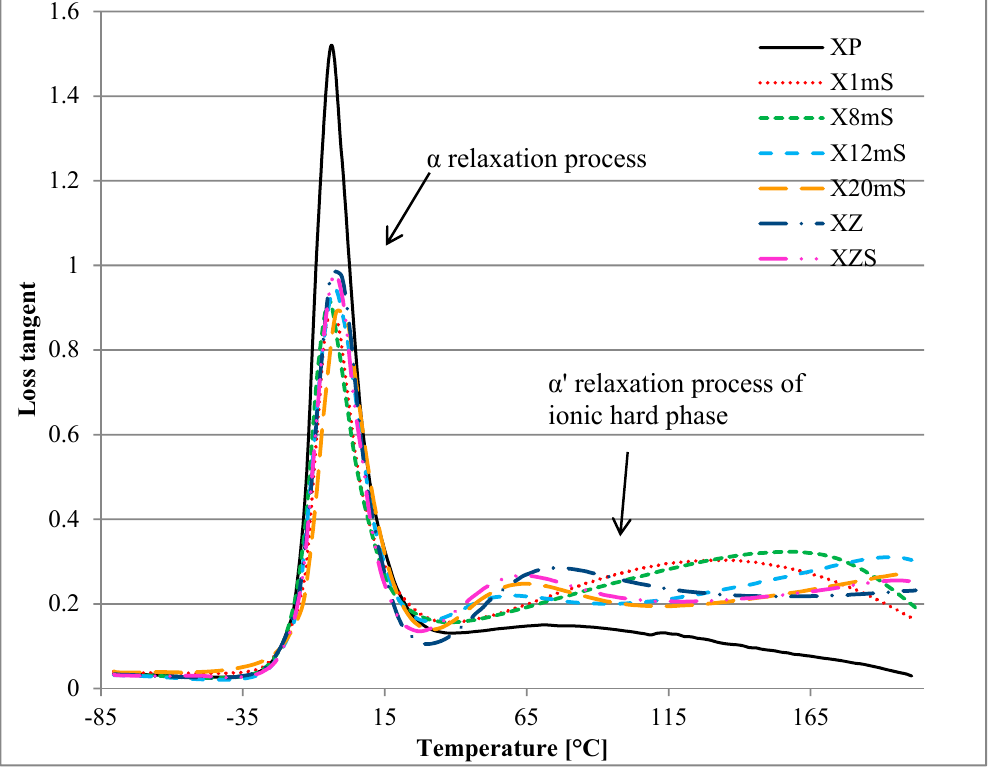
Figure 1. The effect of crosslinking substances on loss tangent (tan δ ) of XNBR vulcanizates at 5 Hz versus temperature ( T ).